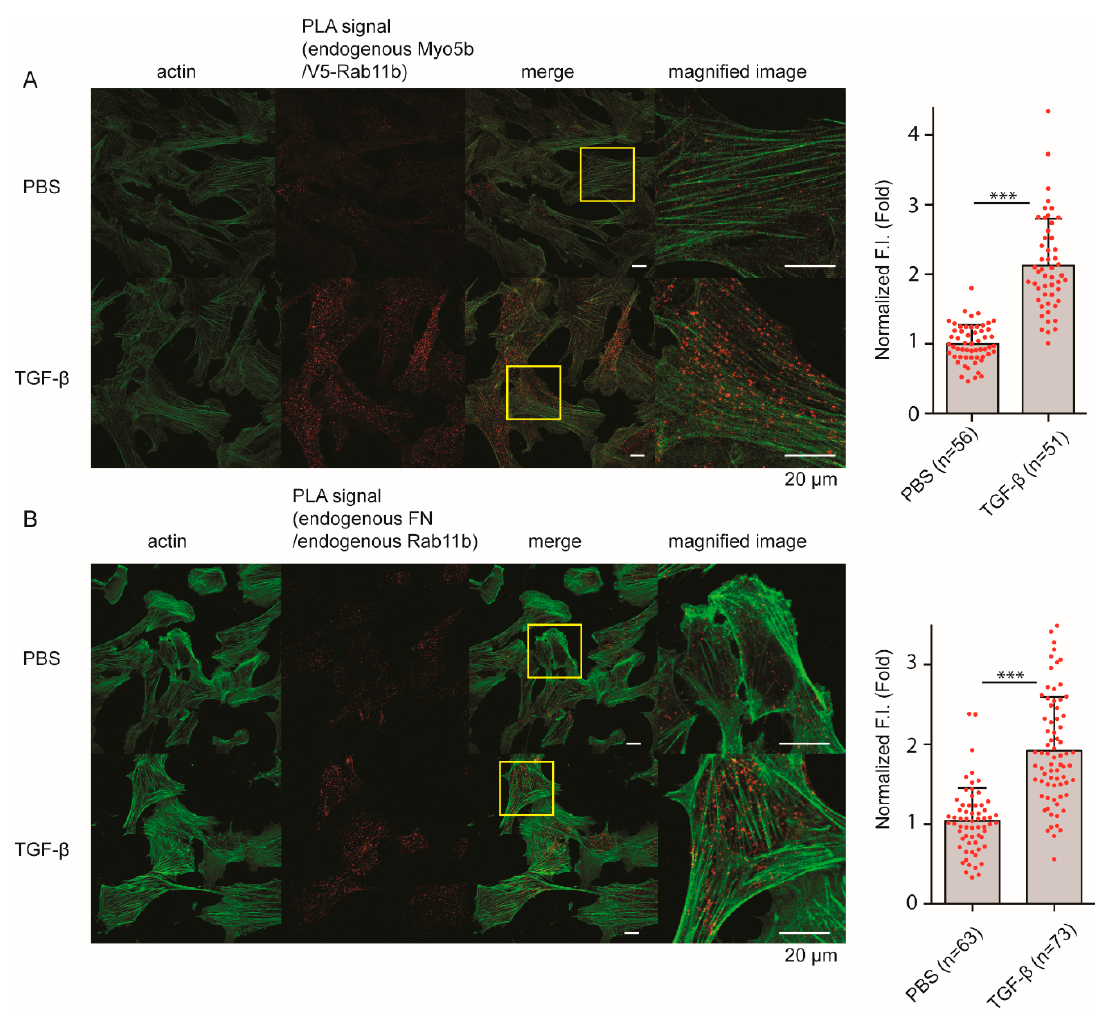
Figure 8. TGF- β increases Proximity ligation signal between Myo5b and Rab11b, and FN1 and Rab11b, respectively. Confocal images of HPMCs with proximity ligation assay. Proximity ligation signals were shown in red. ( A ) Effect of TGF- β stimulation on Proximity ligation signal between Myo5b and V5-Rab11b. V5-Rab11b was expressed in HPMCs for 16 h and proximity ligation assay was performed. Endogenous Myo5b and V5-Rab11b were stained with anti-Myo5b- and anti-v5-antibodies, respectively. Left, Representative confocal images. Magnified images of the boxed area are shown in the right panels. Right, Statistical representation (mean ± SD). *** p < 0.001. ( B ) Effect of TGF- β stimulation on Proximity ligation signal between endogenous FN1 and endogenous Rab11b. Endogenous Rab11b and FN1 were stained with specific antibodies, respectively. Left, Representative confocal image. Magnified images of the boxed area are shown in the right panels. Right, Statistical representation. Scale bar; 20 μ m. The red spots in bar graphs display the distribution of data points.